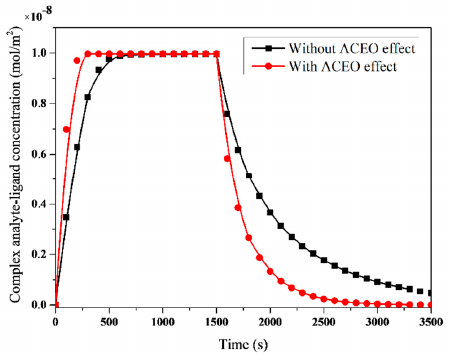
Figure 4. Temporal evolution of the analyte–ligand complex concentration with or without applying voltage.